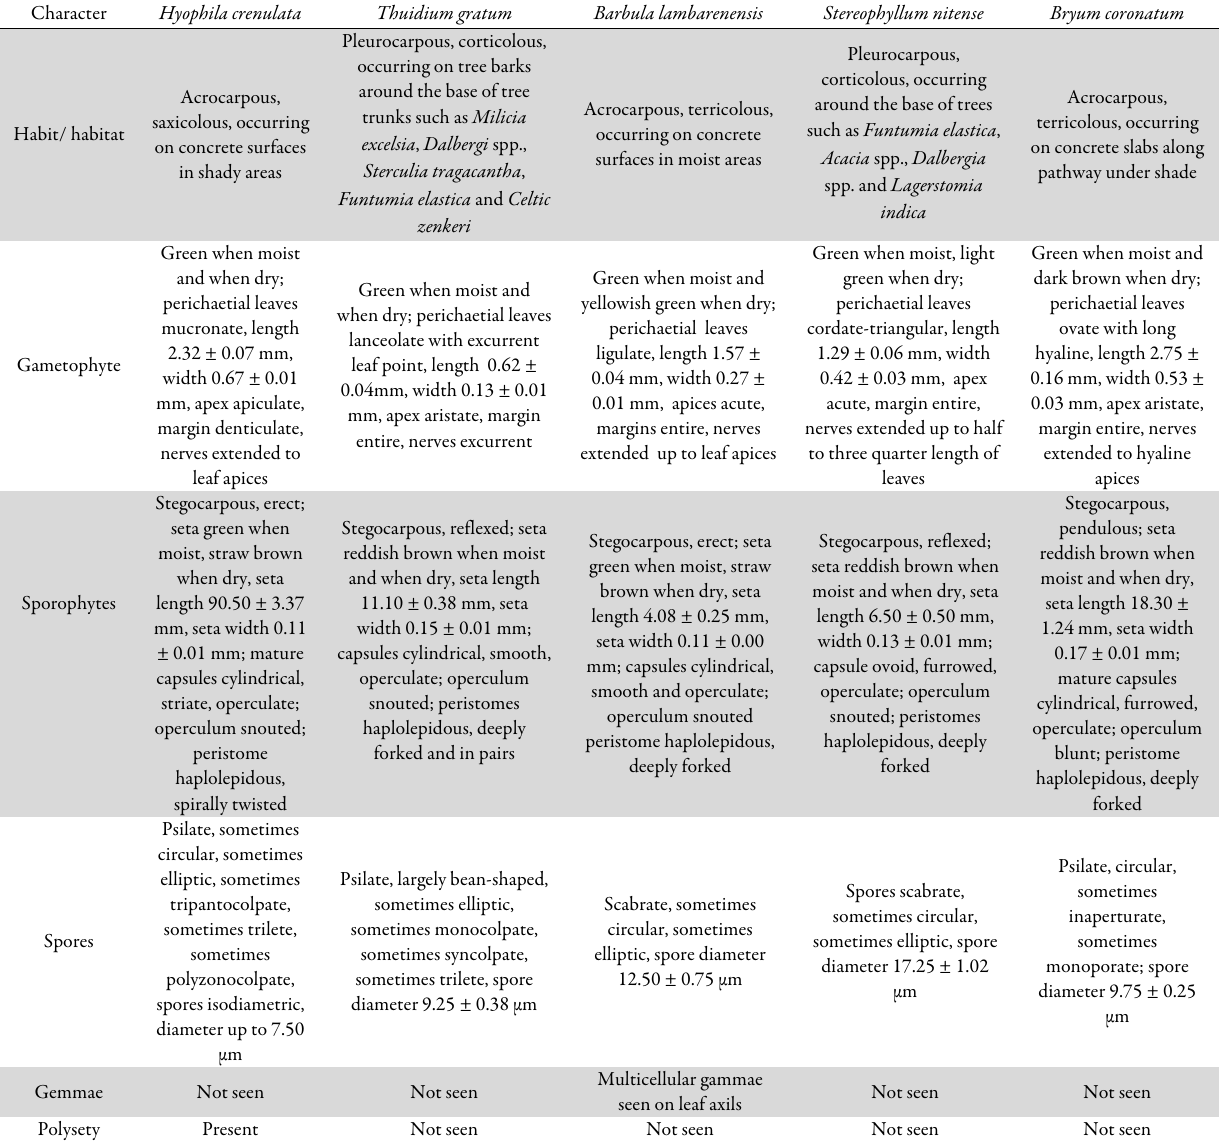
Table 2. Comparative morphology of the moss species